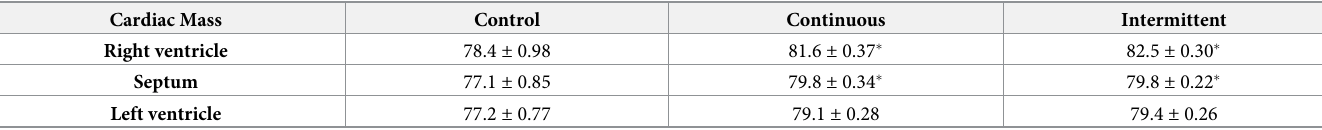
n = 6 (control group); n = 7 (study groups); Values (%) = mean ± standard error. � p < 0.002 compared to respective control group values.